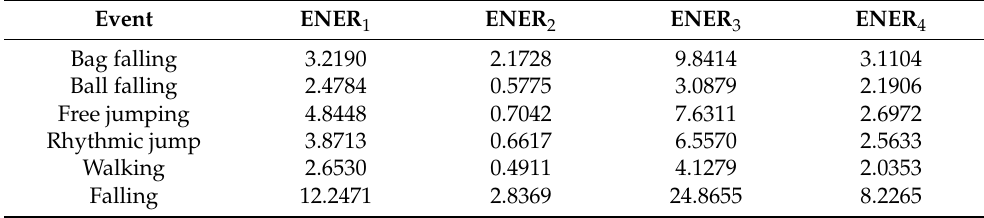
Table 3. Typical eigenvector at excitation position 1 of energy feature set.